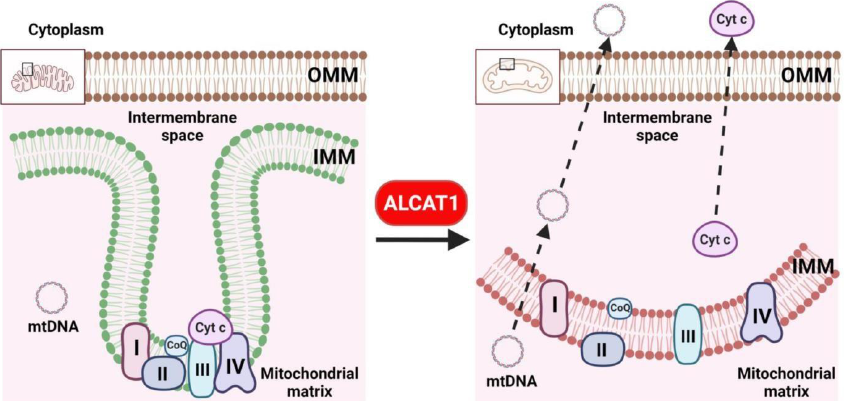
Figure 3. CL remodeling by ALCAT1 leads to a loss mitochondrial membrane curvature, oxidative stress, and defective oxidative phosphorylation. CL is required for the curvature of the inner mitochondrial membrane which plays critical role in supporting the function of mitochondrial respiration complexes. CL remodeling by ALCAT1 causes depletion of CL, leading to a loss of cisterna structure, oxidative stress, defective oxidative phosphorylation, and cytosolic release of mtDNA and cytochrome c .